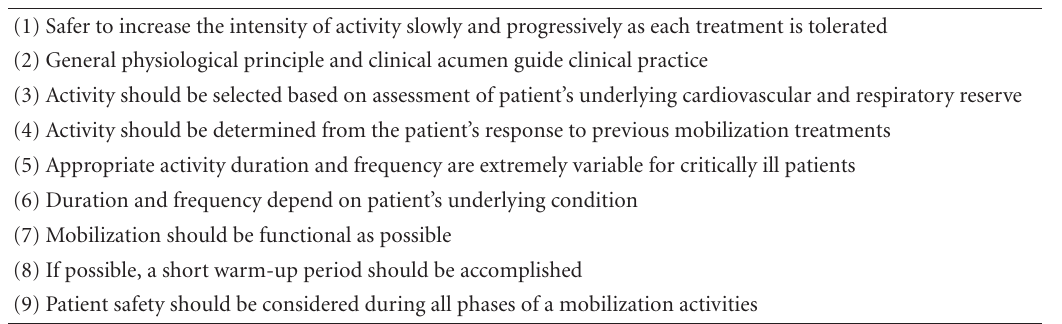
Table 2: Stiller safety considerations for mobilizing critically ill patients (2007).